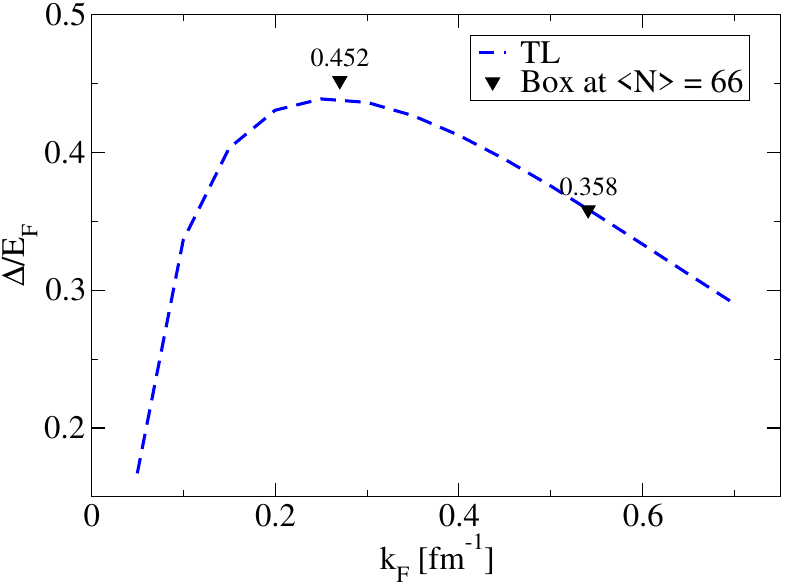
Figure 1. The pairing gap at the thermodynamic limit (TL) divided by the Fermi energy as a function of the Fermi momentum k F . Additionally plotted are the pairing gaps for (cid:104) N (cid:105) = 66 at k F a = − 10 and −